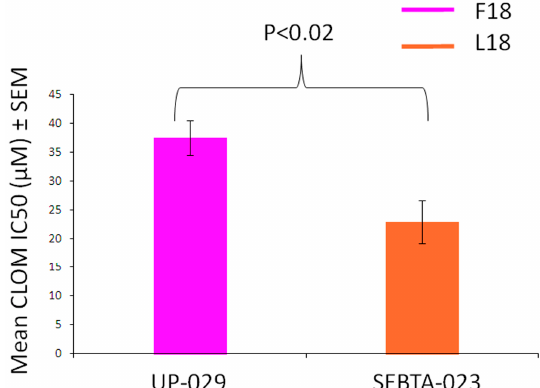
Figure 6. Clomipramine sensitivity of both non-carrier UP-029 and F18L-carrier SEBTA-023 primary adult glioblastoma cell cultures over a period of 72 h. The proliferation of cells measured using the RealTime-Glo™ MT Cell Viability Assay (Promega) without clomipramine (0 μ M) and different doses of clomipramine (range 5–50 μ M) was monitored by measuring cumulative luminescence generated by a pro-substrate being converted into a substrate in viable cells at 1, 3, 6, 24, 48 and 72 h. The proliferation of cells treated with clomipramine were then normalised to the without clomipramine control at each time point. The normalised viability curves were then used to calculate the clomipramine IC50 ( μ M) values for each cell line (all time points combined). Each cell line, at each time point and concentration (including 0 μ M), was measured in triplicate on three independent occasions giving a mean value ± SEM based on n = 9 in each case.